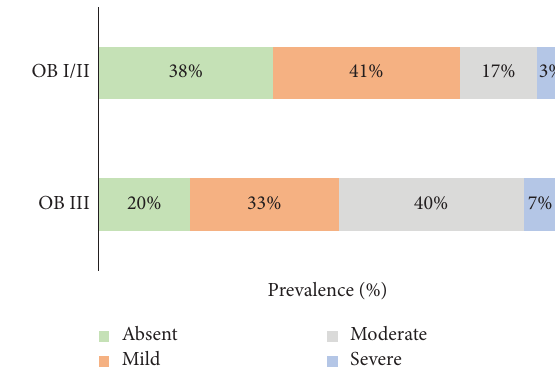
Figure 3: Prevalence of nonalcoholic fatty liver disease. Hepatic steatosis was graded according to ultrasound imaging. Distinct grade (mild, moderate, and severe) was converted to ordinal number and the Mann–Whitney test was performed ( p > 0 .